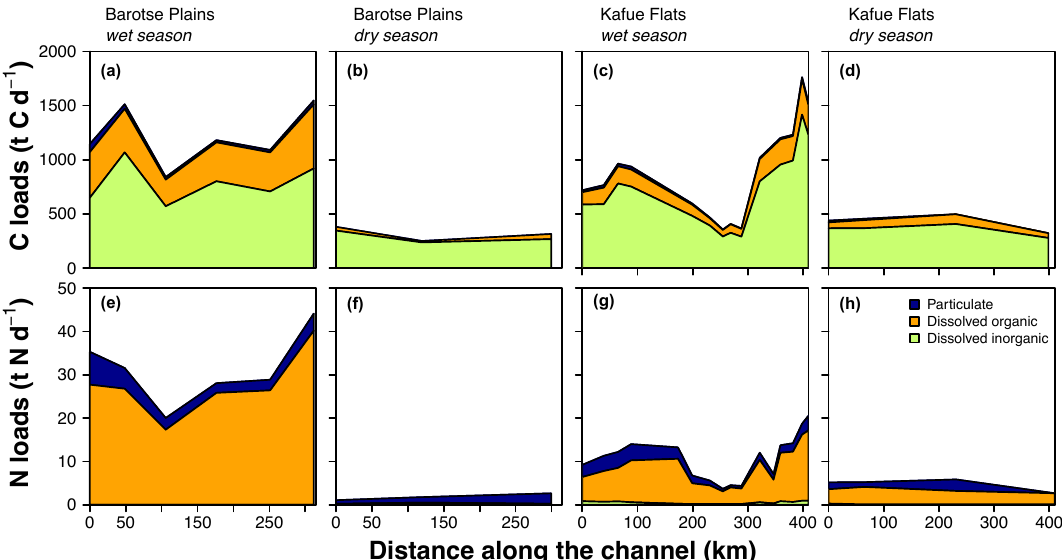
Figure 5. Dissolved and particulate carbon and nitrogen loads along the Barotse Plains and the Kafue Flats during wet and dry seasons. The loads of particulate carbon and nitrogen at the two most downstream locations in the Kafue Flats could not be determined for the dry season due to a lack of POC and PN